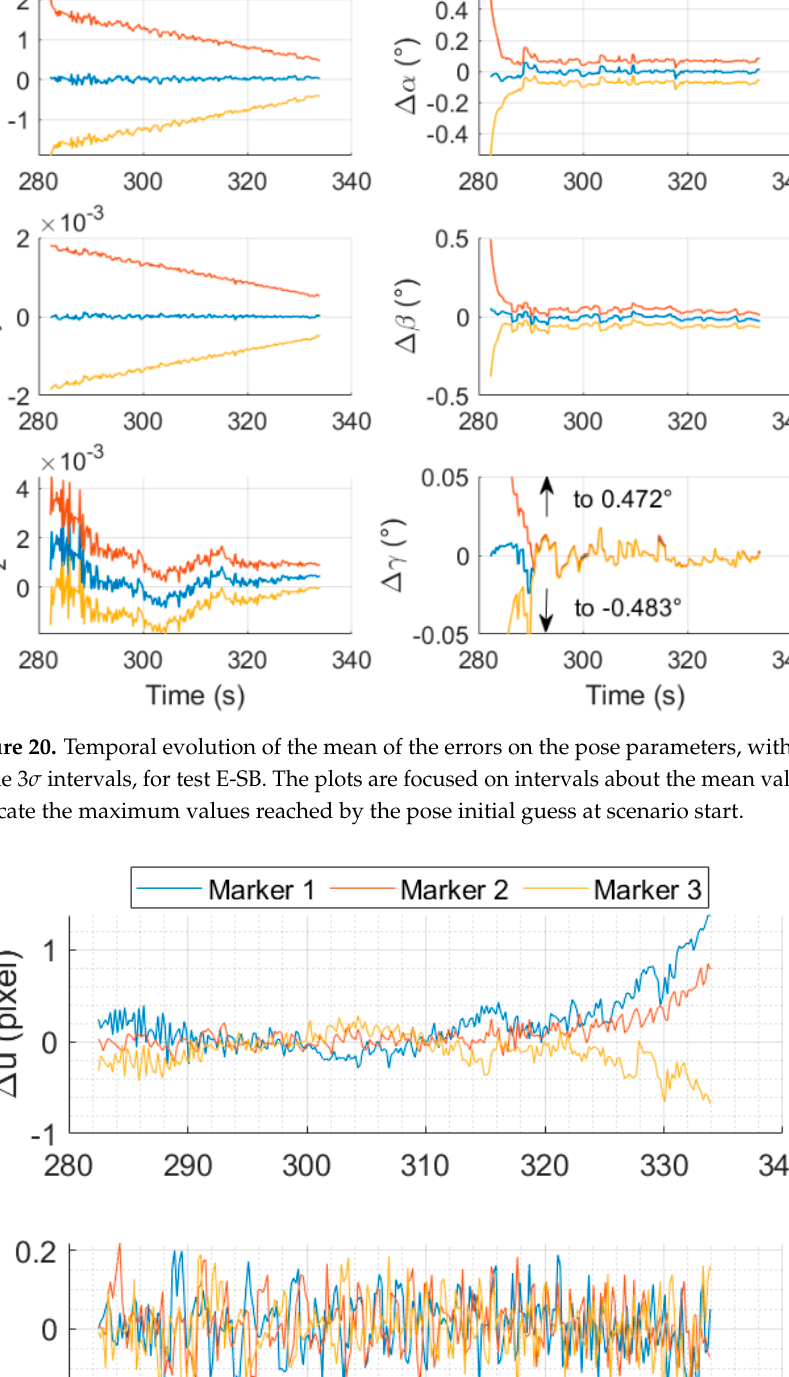
Figure 21. Temporal evolution of the centroiding errors over a single simulation for test case E-SB.